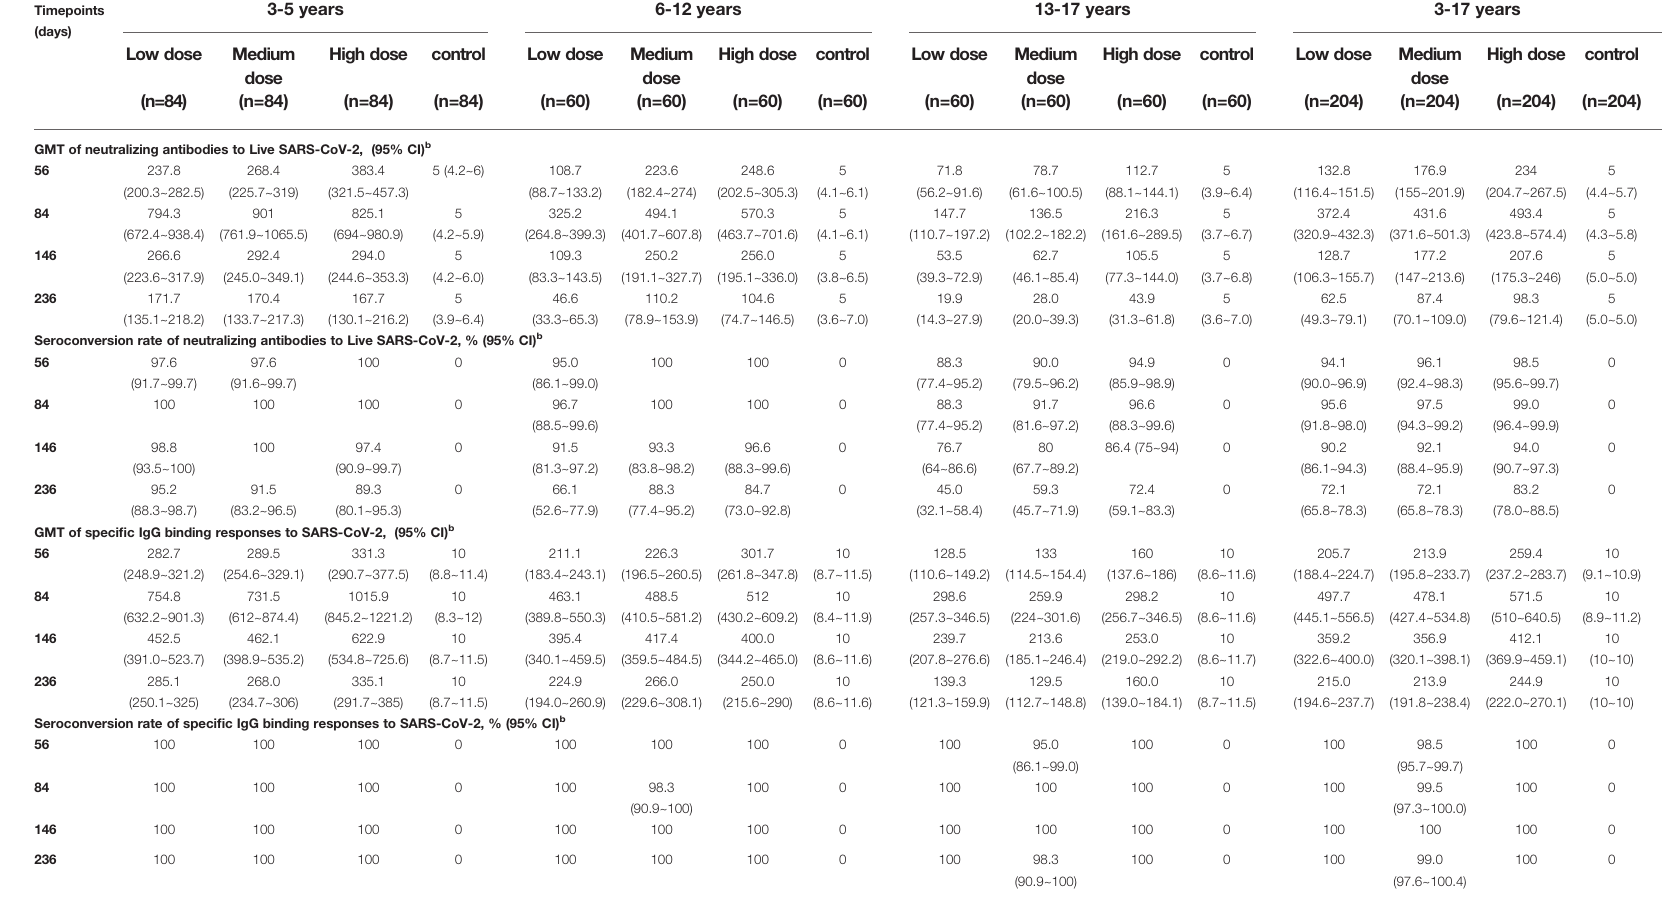
TABLE 3 | Antibody responses in the phase 1/2 trial a